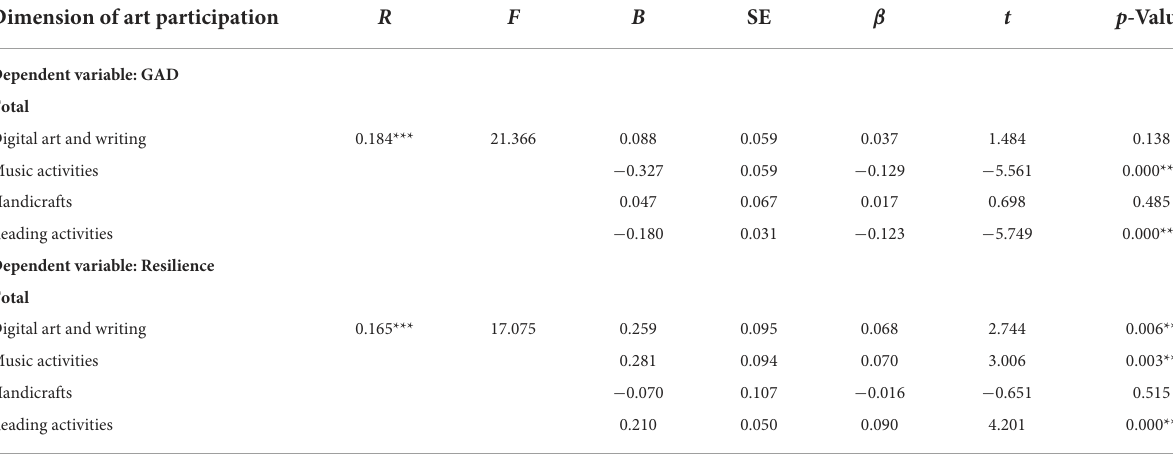
TABLE 8 Hierarchical multiple linear regression for predicting anxiety symptoms. Dimension of art